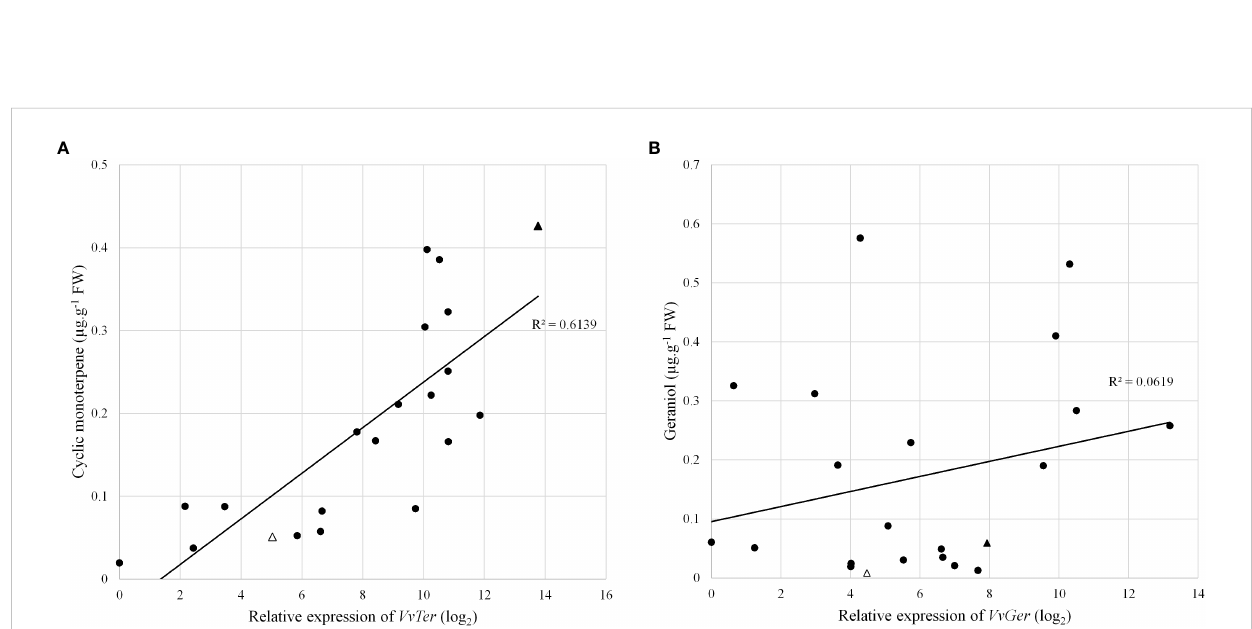
FIGURE 6 (A) VvTer expression compared to cyclic monoterpene content and (B) VvGer expression compared to geraniol content. Gene expression analysis and volatile quanti fi cation was done using pre-veraison berry skins. Circles represent progeny with the VvDXS1 SNP (GT), triangles represent the parents 'Deckrot' (empty) and G1-7720 ( fi lled).